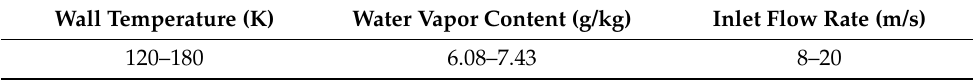
Table 2. Numerical calculation parameters for tube bundle